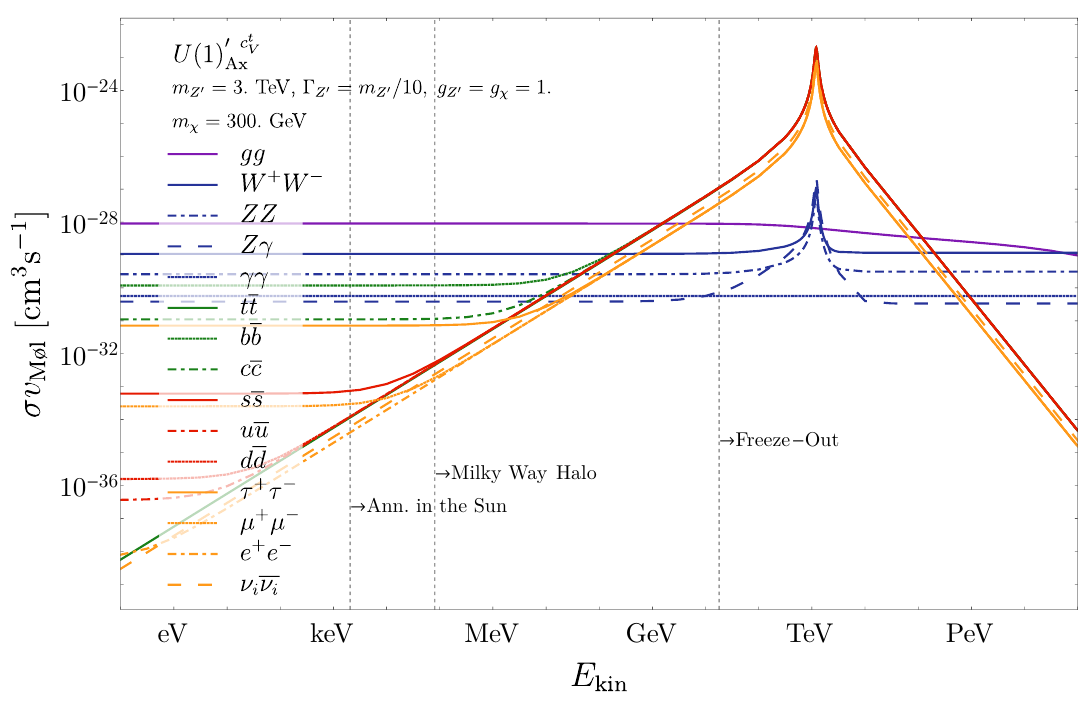
t Figure 3 . Annihilation cross sections in the U(1) 0 c V ax model as a function of the DM kinetic energy within the EFT that we describe. The blue curves indicate gauge boson (cid:12)nal states that receive contributions from anomalies. Annihilations into heavy quarks, light quarks, and leptons are shown in green, red, and yellow, respectively. Kinetic energies corresponding to DM in the Sun, the Milky Way halo, and at freezeout are indicated. Note that above the scale 100 TeV the EFT cannot (cid:24) give the correct solution due to the inevitable unitarity